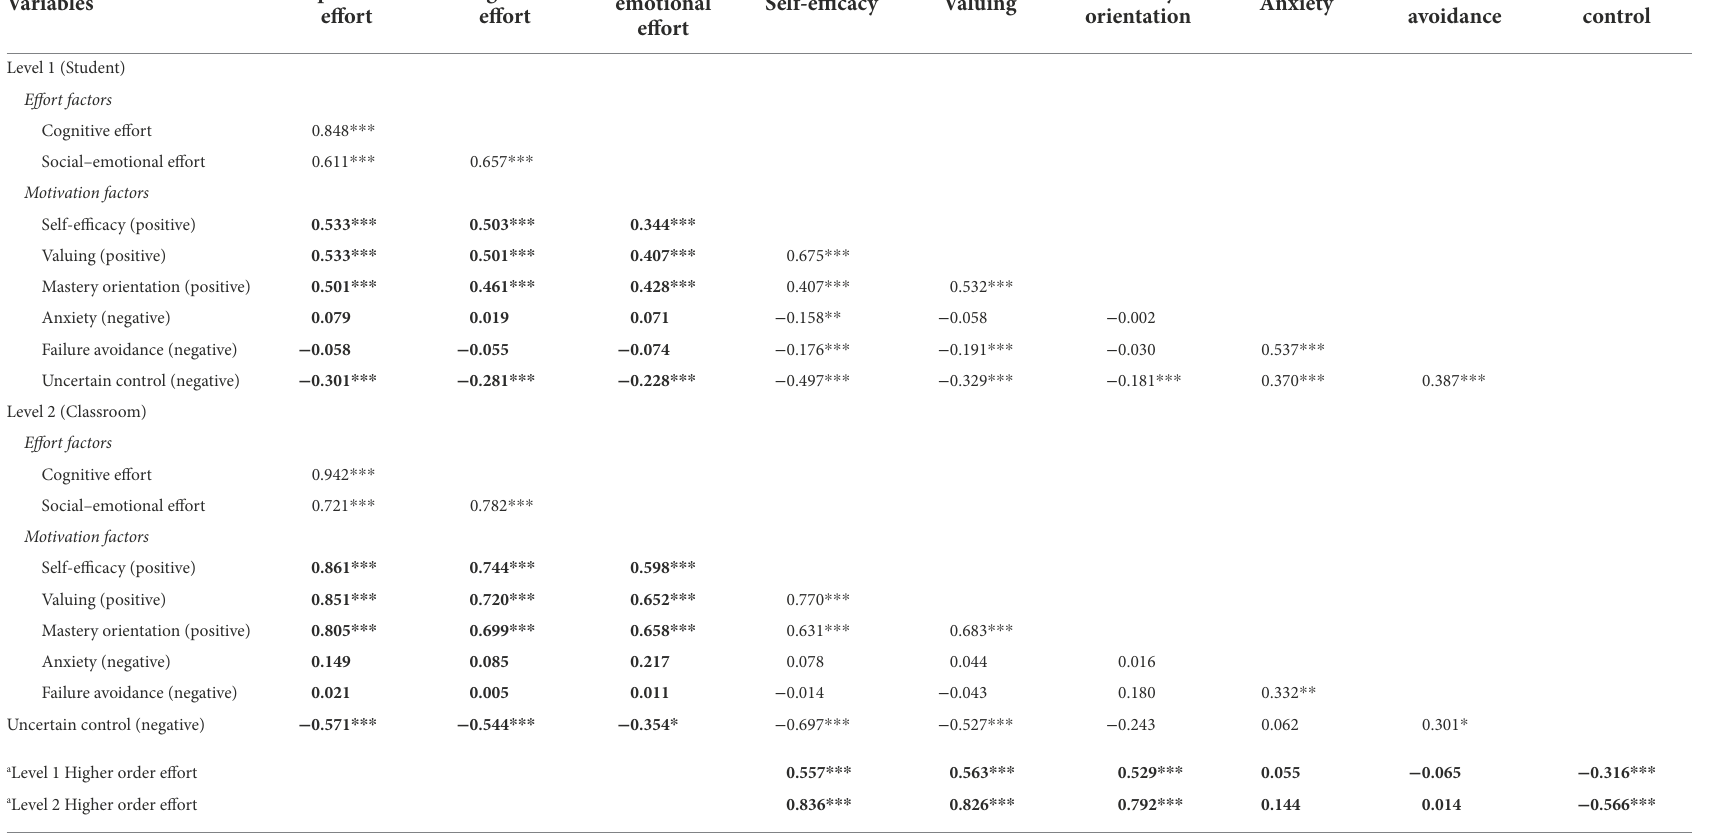
TABLE 2 Multilevel correlation matrix within and between motivation and effort factors.